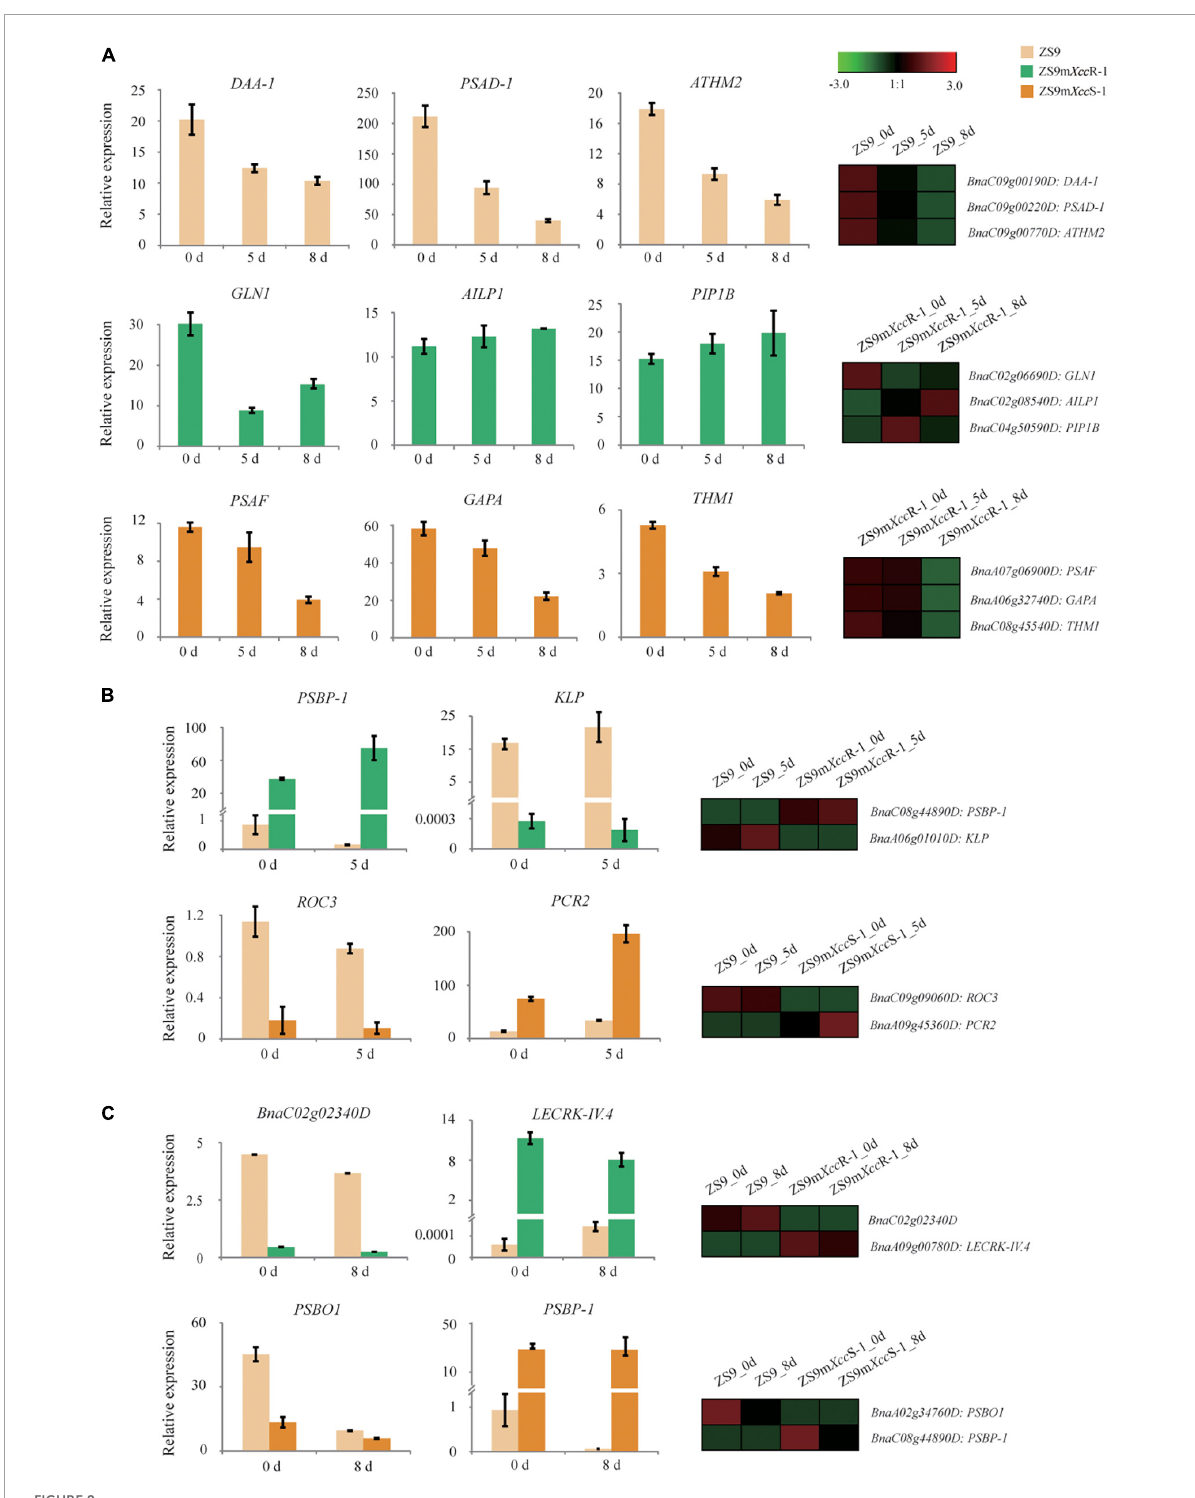
FIGURE8 Validation of DEG expression patterns in B. napus upon Xcc inoculation using Q-RT-PCR. (A) Expression levels of representative DEGs with different patterns in ZS9 (top), ZS9m Xcc R-1 (middle), and ZS9m Xcc S-1 (lower panel) at 0, 5, and 8 dpi, respectively. (B) Expression levels of two selected DEGs in ZS9 vs. ZS9 Xcc R-1 (top) and ZS9 vs. ZS9 Xcc S-1 (down) at 0 and 5 dpi, respectively. (C) Expression levels of two selected DEGs in ZS9 vs. ZS9 Xcc R-1 (top) and ZS9 vs. ZS9 Xcc S-1 (down) at 0 and 8 dpi, respectively. Differential expression patterns of selected genes obtained by RNA-seq analysis are shown at the right